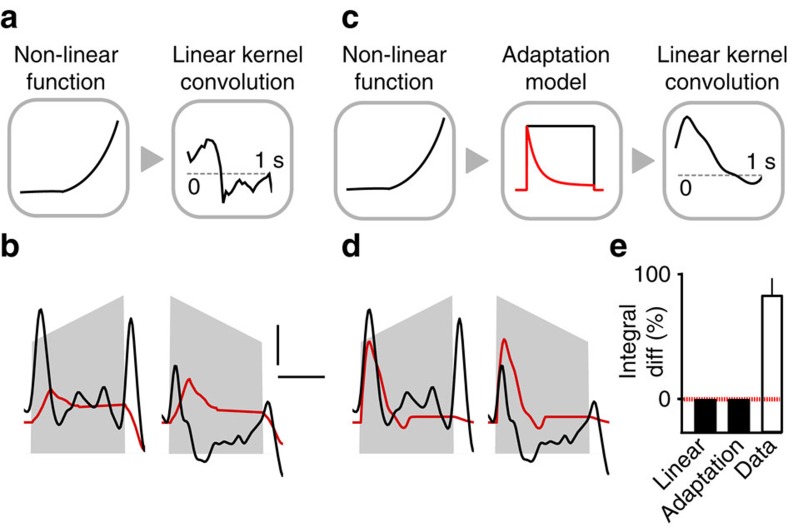
Cortical response asymmetry is a nonlinear effect.(a) Sketch of the linear filter model. The input signal is scaled by a nonlinear function (left) and then goes through a linear kernel (right) to obtain the neuronal response. (b) Best fit by the linear model of the population responses to the 2 s white noise up- and down-ramps. Scale bars, vertical 0.1% ΔF/F, horizontal 1 s. (c) Sketch of the adaption model. The input signal is scaled by a nonlinear function (left), then undergoes adaptation (middle) and finally passes through a linear kernel (right). (d) Best fit by the adaptation model of the population responses to the 2 s white noise up- and down-ramps. (e) Integral differences between up- and down-ramps for the linear and adaptation models for any choice of parameters and any ramp waveform (analytical result) versus experimental integral differences for the 2 s white noise ramps.